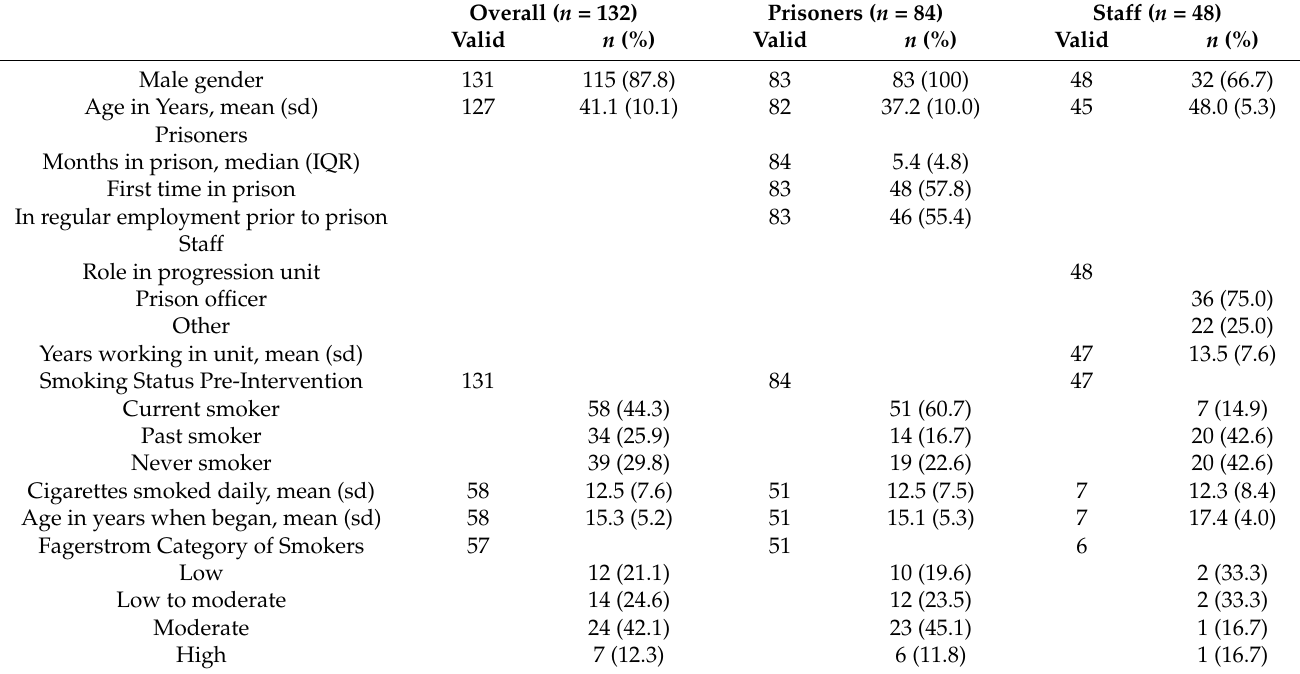
Table 1. Sociodemographic and Smoking Characteristics of Study